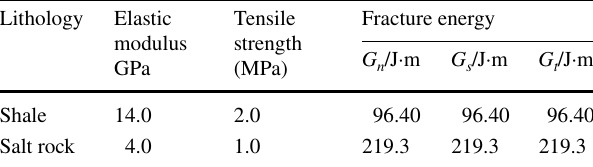
Table 6 Material parameters of cohesive element Lithology